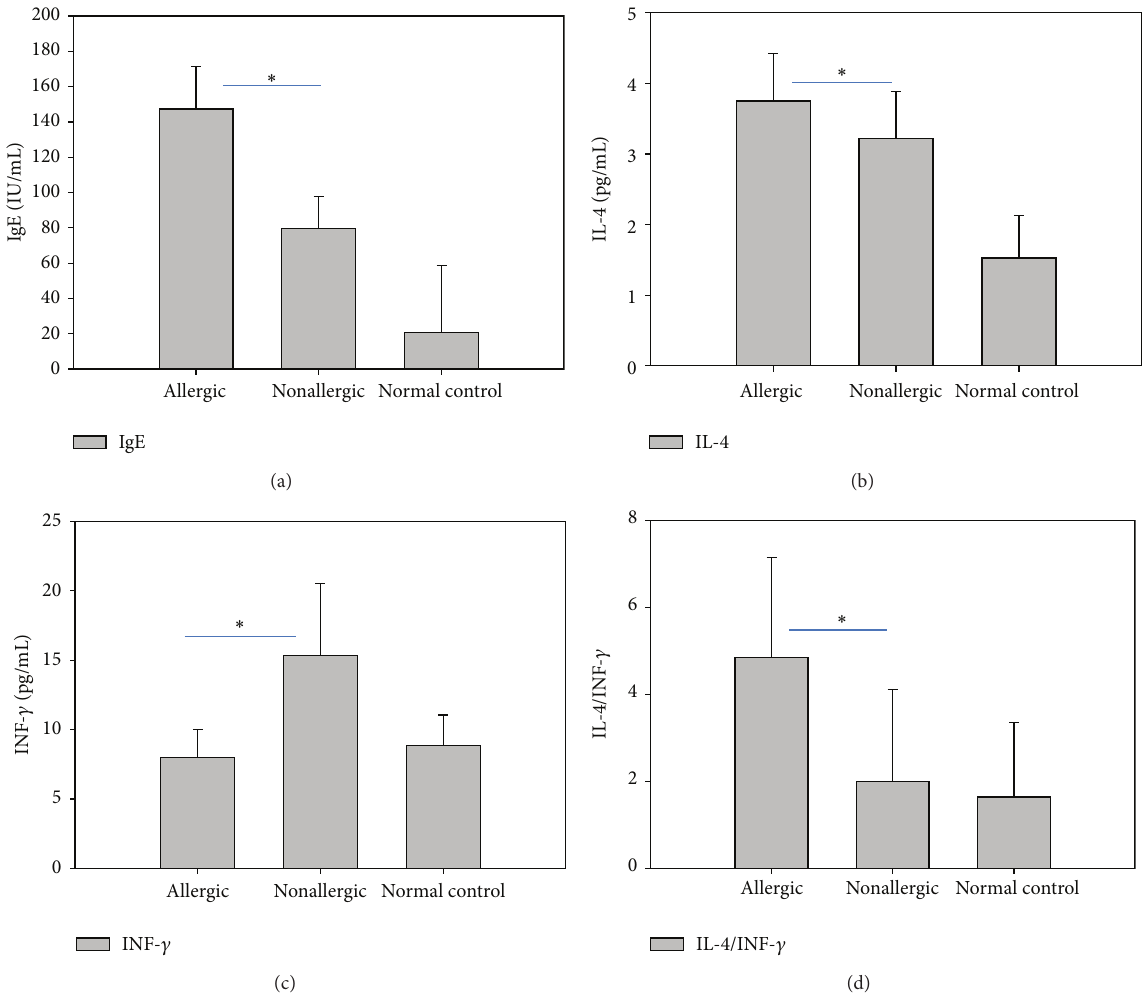
Figure 2: The IgE and serum cytokine levels for MPP patients with or without allergic conditions. Levels of IgE and serum cytokines were measured for 𝑛 = 402 MPP patients with concomitant allergic conditions and 𝑛 = 278 MPP patients without allergic conditions. The results for 𝑛 = 50 control subjects without pneumonia are shown for comparison. Results represent the mean ± standard deviation. ∗ 𝑃 < 0.01 for allergic versus nonallergic